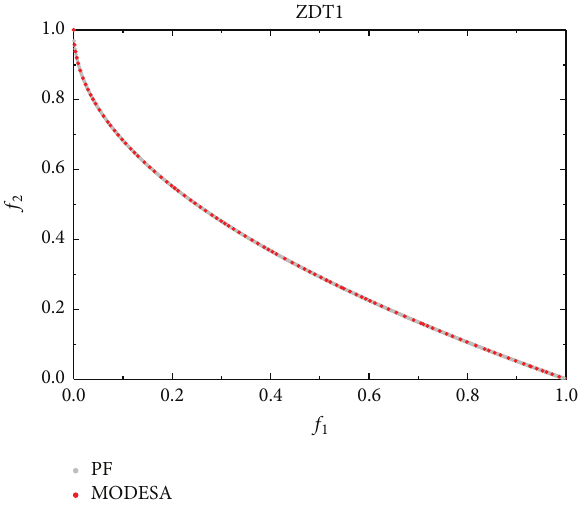
Figure 1: Plots of the nondominated solutions with the lowest IGD- metric values found by MODESA in 10 runs in the objective space on ZDT1 where 𝑁 = 100 and 𝑇 = 250 .